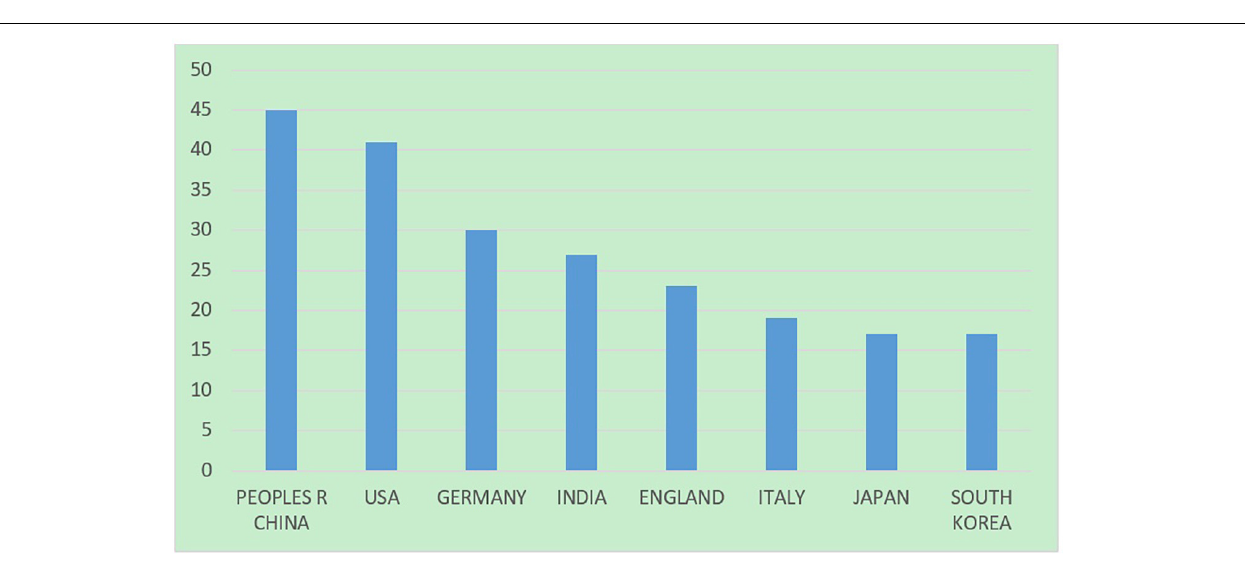
FIGURE 3 | Number of documents by countries in BCI and emotions